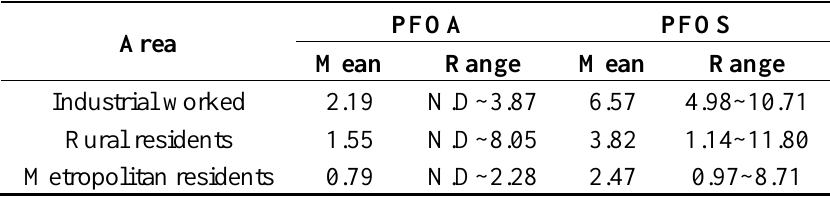
Table 4. Levels of PFOA and PFOS in regional areas